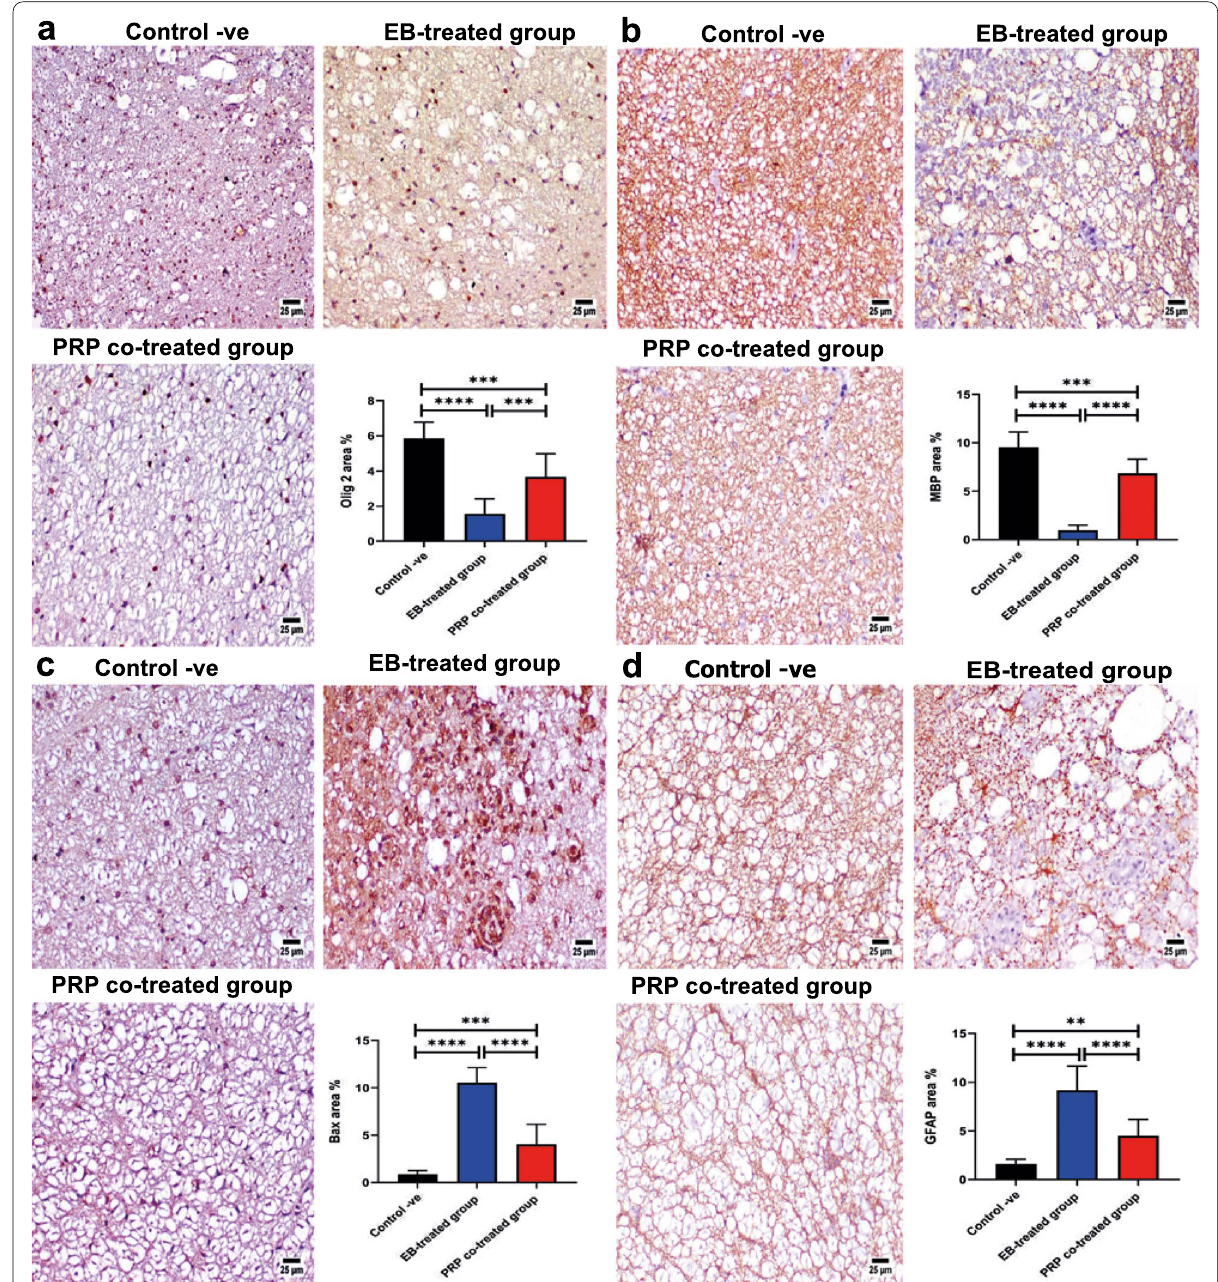
Fig. 8 Photomicrographs of the spinal cord. a Olig2 expression; the EB-treated group reveals reduced immune expression with noticeable restored value in the PRP co-treated group. b MBP expression; the EB-treated group shows reduced expression with significant restored value in the PRP co-treated group. Charts showing the quantification of positive staining as area percent. Data were presented as means difference was considered at P < 0.05. c Bax expression exhibiting increased positive staining in the EB-treated group with a marked reduction in the PRP co-treated group. d GFAP expression showing increased positive immunostaining in the EB-treated group with a marked reduction in the PRP co-treated group. Charts showing the quantification of positive staining as area percent. Data were presented as means difference was considered at P <